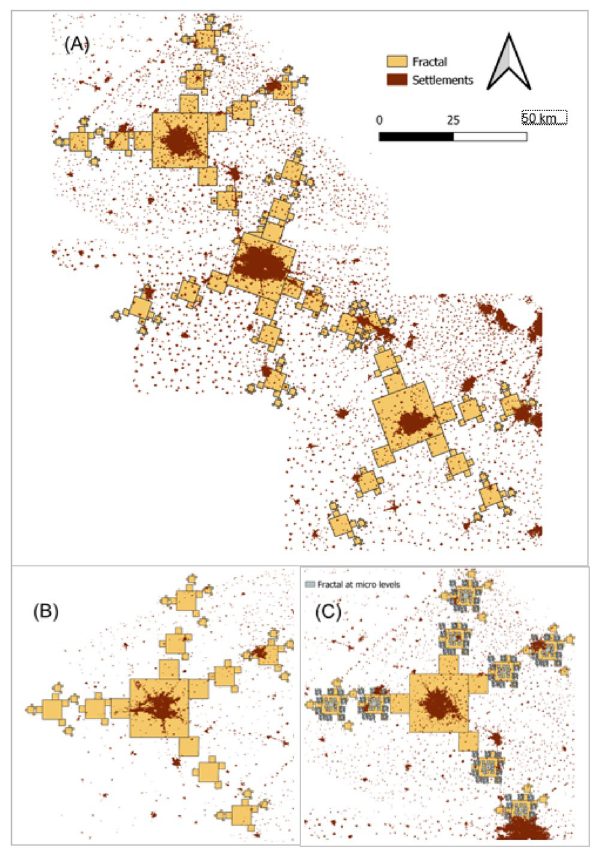
Figure 6. ( A ) Sierpinski Carpet fractals projected to the landscape, centered on the N-Indian mega settlements of Jalandhar, Ludhiana, and Patiala (Settlement binary map of 2016). The fractals were generated using Fractalopolis model at iteration 3 and ( B ) at Amritsar, ( C ) at micro level starting at iteration 2 in